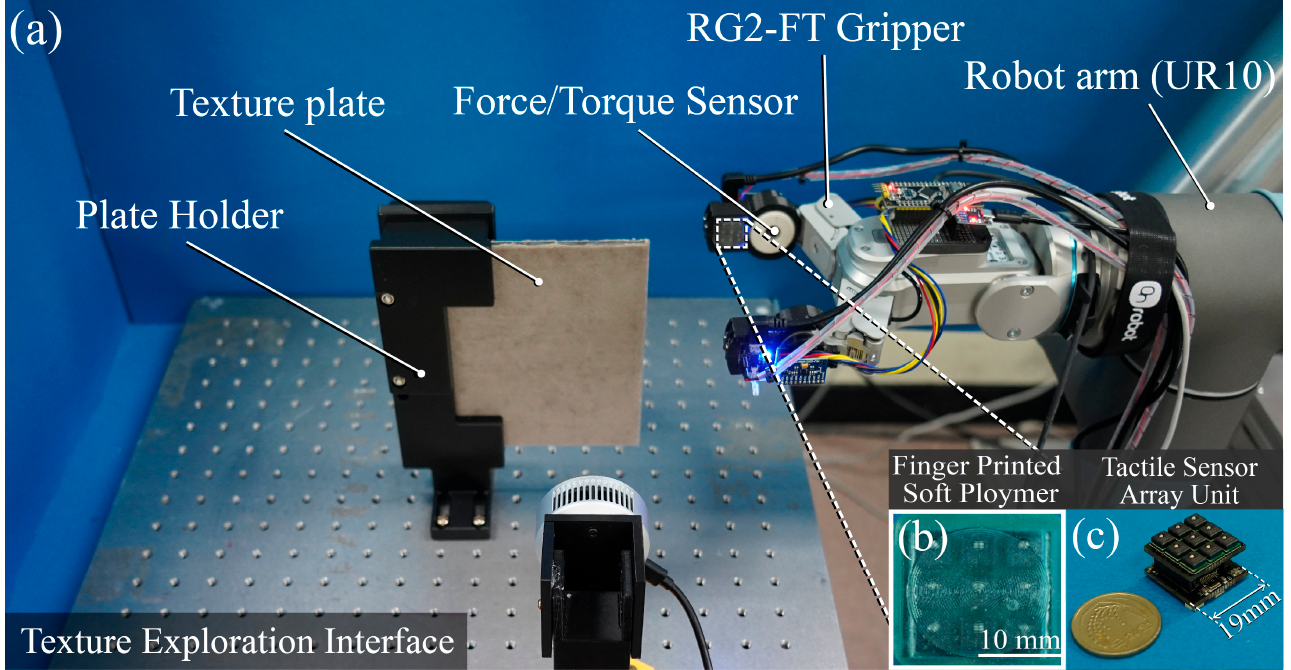
Figure 1. Used texture exploration interface: ( a ) The tactile sensing system. A 3 × 3 tactile sensor array was attached to each end of the gripper (RG2-FT, OnRobot) equipped with force-torque sensors. The robot arm (UR-10, Universal Robots) was used for texture exploration. ( b ) A tactile sensor array covered with fingerprinted soft polymer. The soft polymer made of elastic resin (Engineering Resin, Formlabs) with a shore hardness of 50 A has a fingerprint’s ridge depth of 0.25 mm, a width thickness of 0.1 mm, and a gap between the ridge of 0.2 mm. ( c ) Photographs of the tactile sensor array module with a coin. The size of the tactile sensor array is 19 mm × 17 mm.